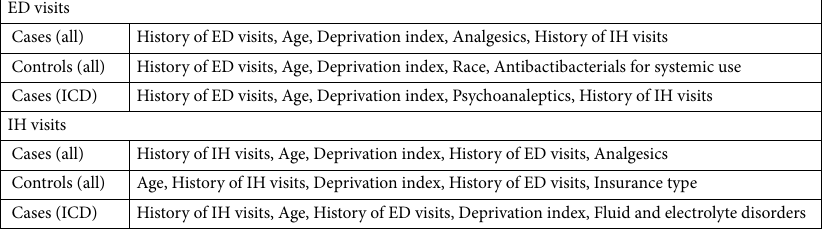
Table 8. Top 5 variables identified in RF for the Intra-cohort models that use the sociodemographic (So), Elixhauser comorbidity conditions (Dx) and ATC medication groups (Rx) exposure